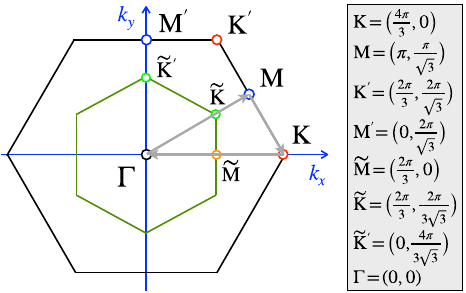
FIG. 5. Full BZ of the triangular lattice (outer hexagon) and magnetic BZ of the three-sublattice structures (inner hexagon), high-symmetry points in units of inverse lattice spacing 1 =a , and the direction of a representative K Γ MK